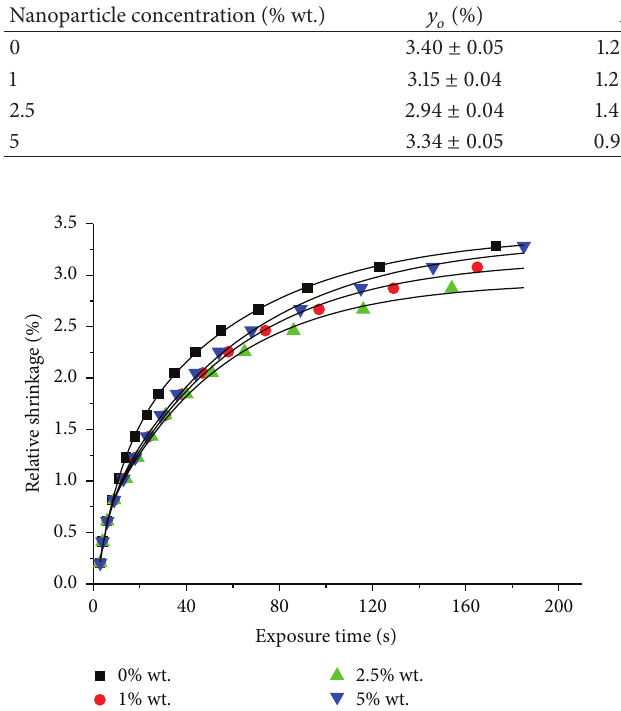
Table 4: Data from double exponential fit of relative shrinkage versus exposure time for BEA-doped AA photopolymer. Nanoparticle concentration (% wt.)